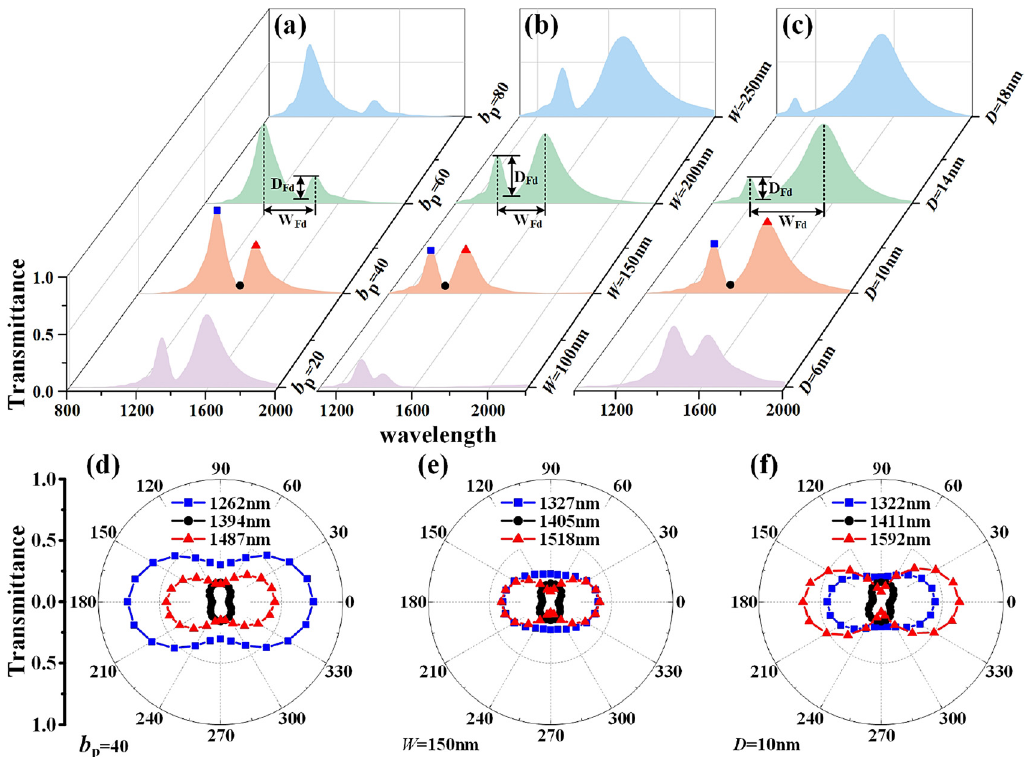
Figure 3: The designability and polarization dependence of the near-infrared plasmonic FR in a hybrid metasurface. (a) Transmitted spectra of the hybrid metasurface with different geometric parameters (a) b p , (b) W , and (c) D in the near-infrared region, respectively. (d – f) Polar plots of the transmittance at the related three wavelengths (corresponding to the blue square, black dot, and red triangle in (a),(b), and(c), respectively)in thehybrid metasurface with (d) b p = 40, (e) W = 150 nm, and(f) D = 10 nm. The otherparameters are the same as Figure 2. FR, Fano